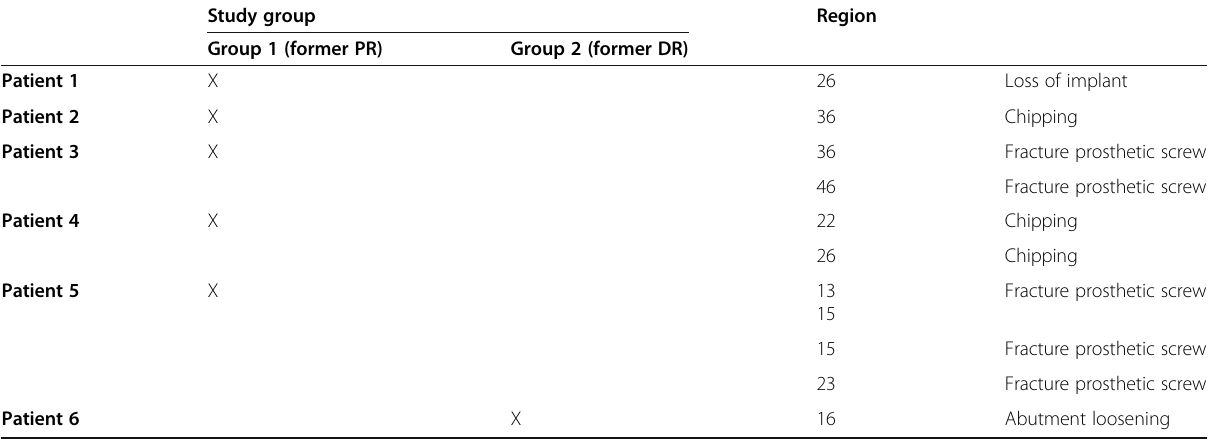
Table 4 Individual complications per group within the first year after the healing period of 3 months Study